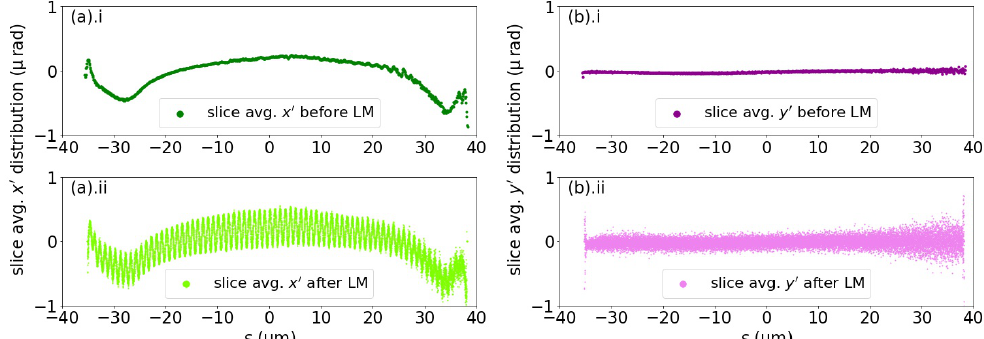
Figure 4. The ( a ) horizontal ( ˆ x ) and ( b ) vertical ( ˆ y ) transverse momentum along the beam. ( a ). i and ( b ). i show the transverse momentum distribution before the laser modulation. ( a ). ii and ( b ). ii show the transverse momentum distribution after the laser modulation. Downstream of the laser modulator, the vertical momentum is slightly perturbed in an uncorrelated manner, but clear modulation is seen on the profile of the horizontal